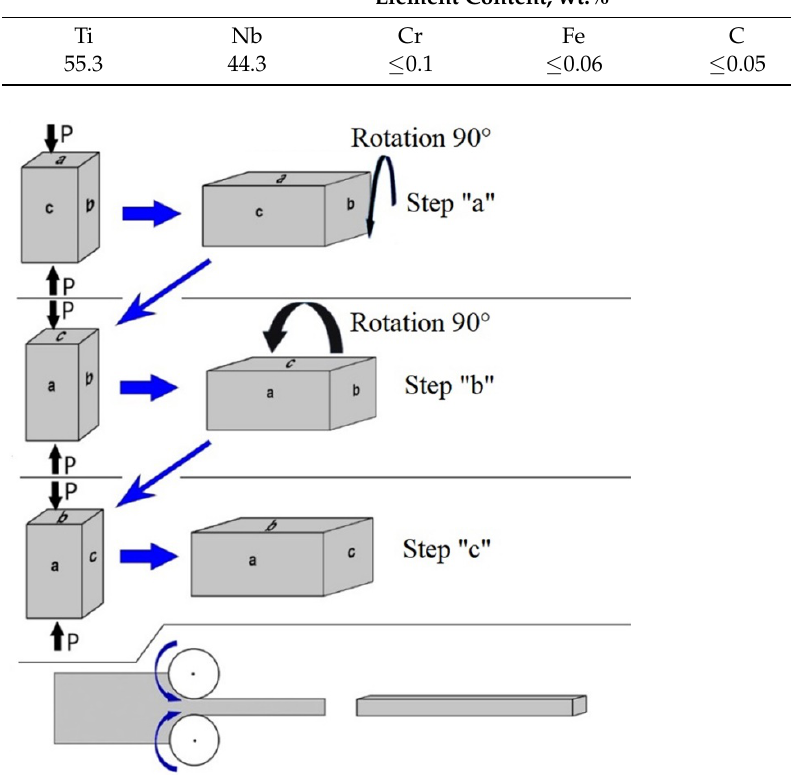
Table 1. Chemical composition of Ti-45Nb alloy. Element Content, wt.%